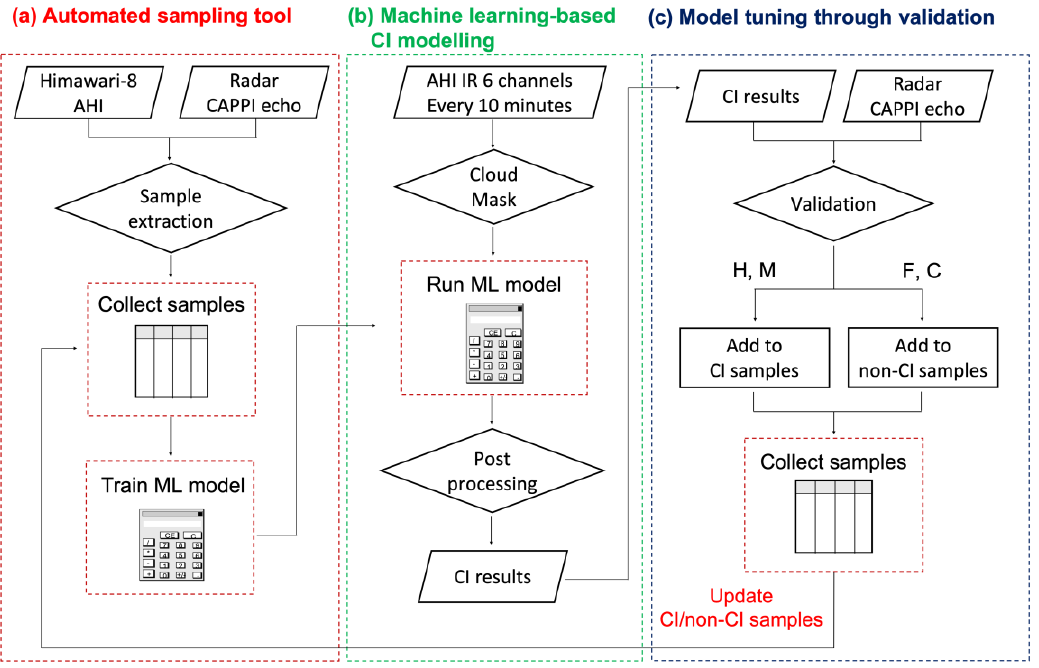
Figure 1. An overall flowchart of this study. The suggested framework is composed as follows: ( a ) The automated sampling tool; ( b ) machine learning-based CI modelling; ( c ) model tuning through validation. ML in ( a ) and ( b ) stands for machine learning.